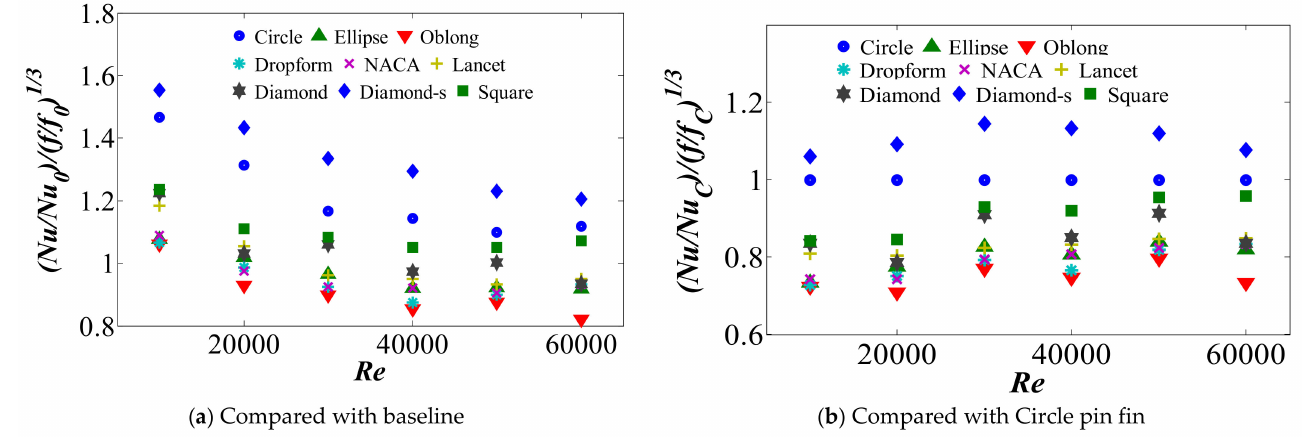
Figure 14. Overall thermal performance